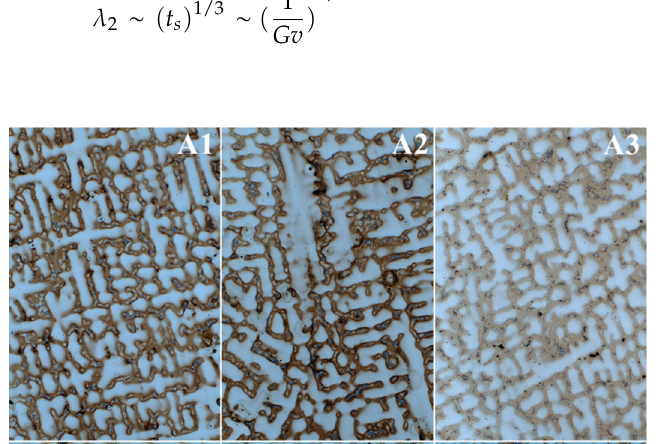
Figure 5. Secondary dendrite arm spacing in fabricated castings. 3.2. Microsegregation of Alloying Elements Studied by SEM-EDX Segregation of alloying elements occurring during solidification influenced substantially the large heterogeneity of microstructure. The coefficient k i = (cid:3004) (cid:3253)(cid:3284) (cid:3004) (cid:3258)(cid:3253)(cid:3284) , namely the ratio of the concentration of alloying element in the centerline of dendrite arms to the concentration in the interdendritic spaces, was calculated and is presented in Figure 6, which shows the irregular distribution of elements. Generally, k i is lower than 1 indicating that the element segregated to interdendritic spaces, while